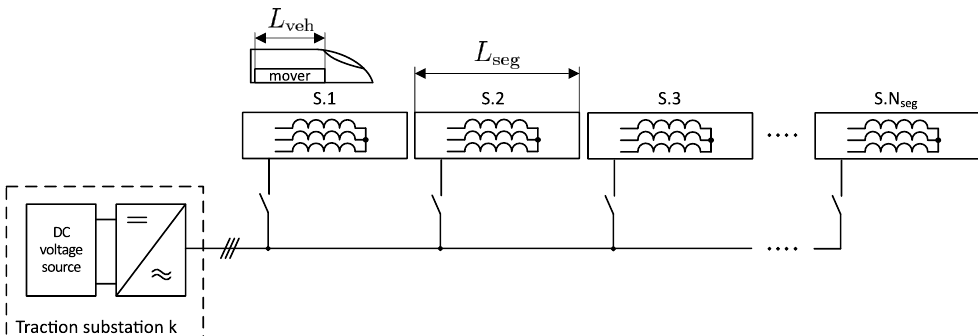
Figure 3. Block diagram of the single-inverter drive